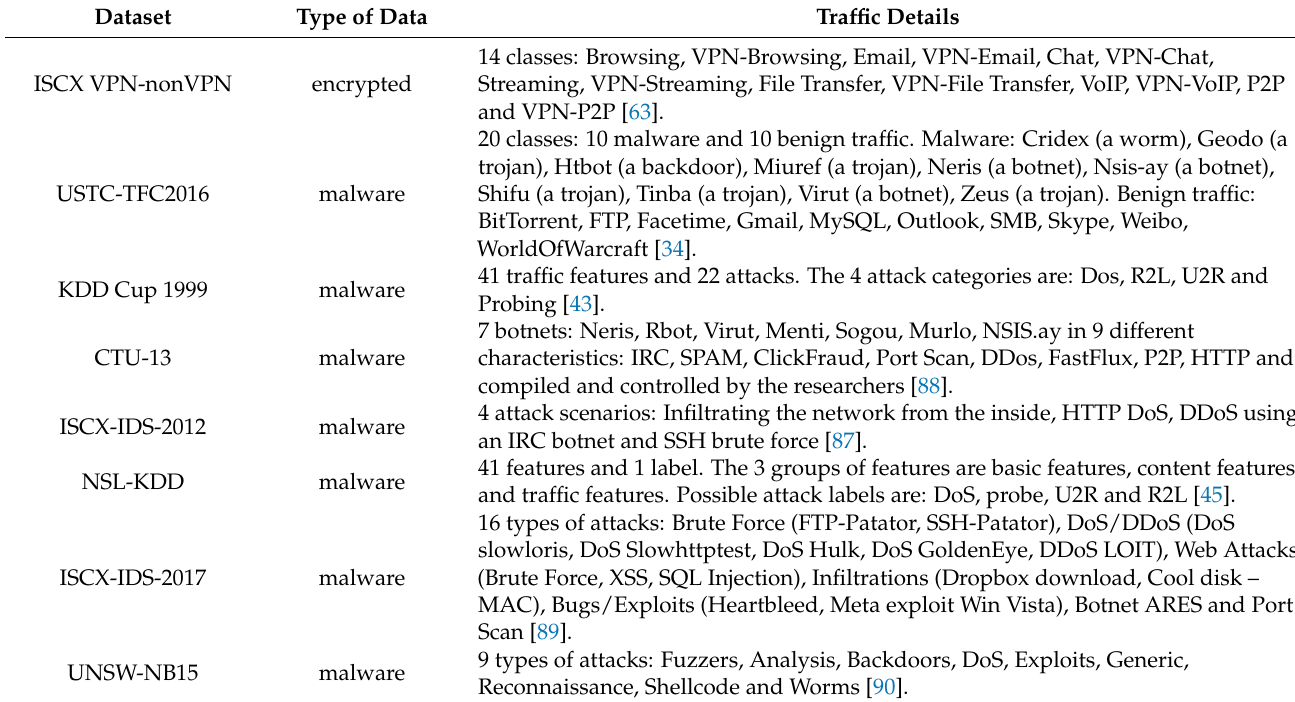
Table 2. The traffic details of the most popular datasets. Datasets are sorted by the number of occurrences in articles. Dataset Type of Data Traffic